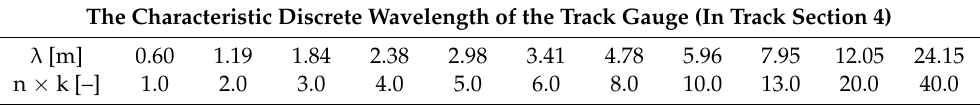
Table 7. Discrete Wavelengths associated with Outliers in FAS of TG in Section 4 (see Figure 9). The Characteristic Discrete Wavelength of the Track Gauge (In Track Section 4)